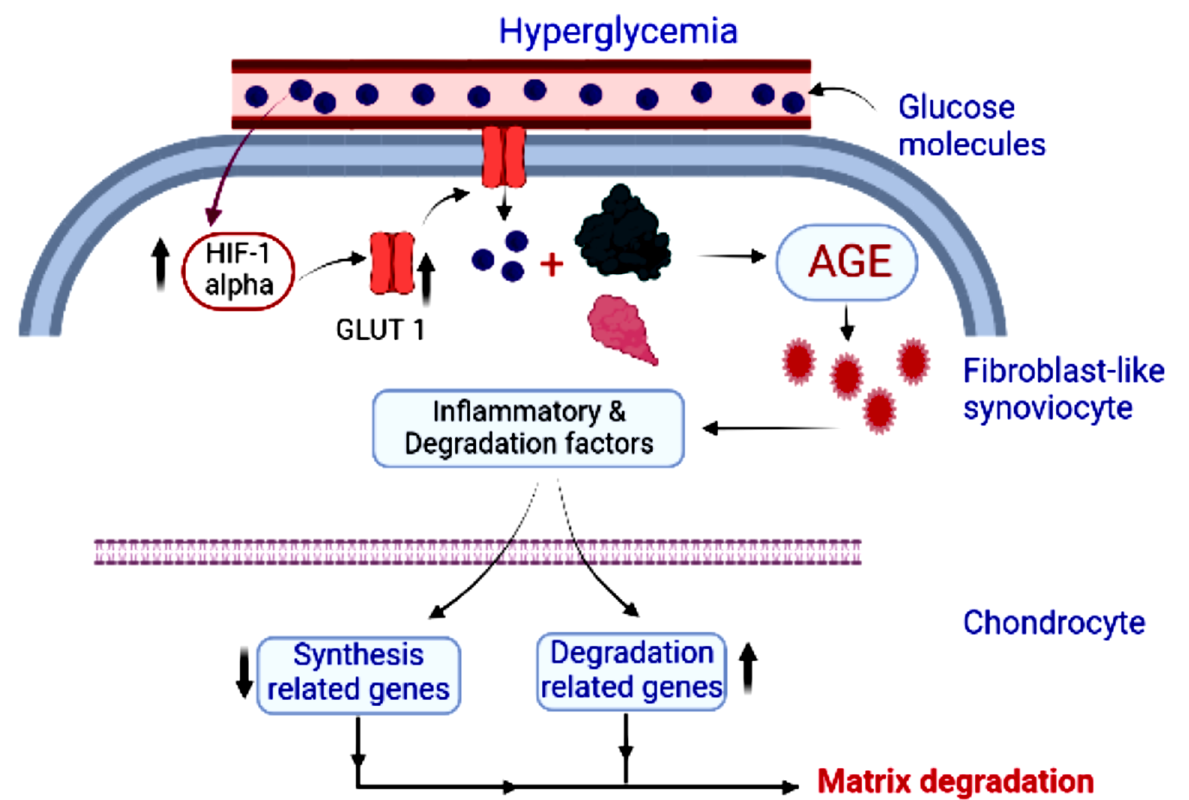
Figure 3. The activation of ERS and the release of proinflammatory substances from the synovium as a result of high glucose levels caused inflammation and degradation of the articular cartilage.